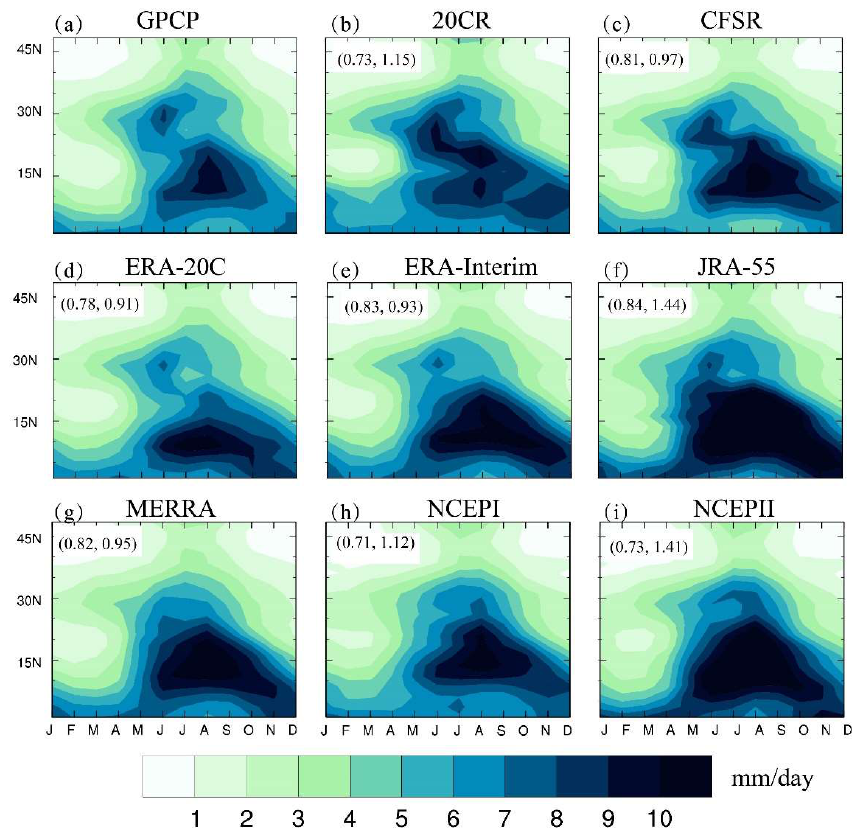
Figure 1. Precipitation latitude-time cross section of observation (( a ) Global Precipitation Climatology Project; GPCP) and different re-analysis datasets ( b–i ) in the East Asian summer monsoon region (0–50° N, 100–140° E) from 1979 to 2010. The number in the upper-left corner of each panel indicates the pattern correlation coefficient ( left ) and the root-mean-square error ( right ) skill of the observed precipitation.